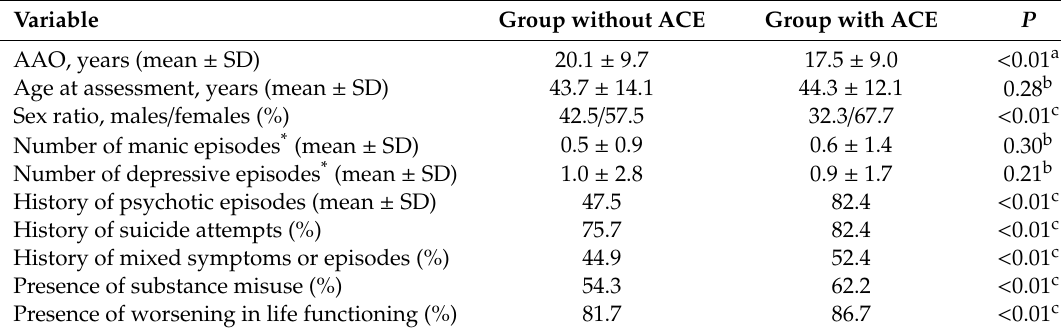
Table 3. Comparison of demographic and clinical variables between groups with and without adverse childhood experience, defined according to CLES